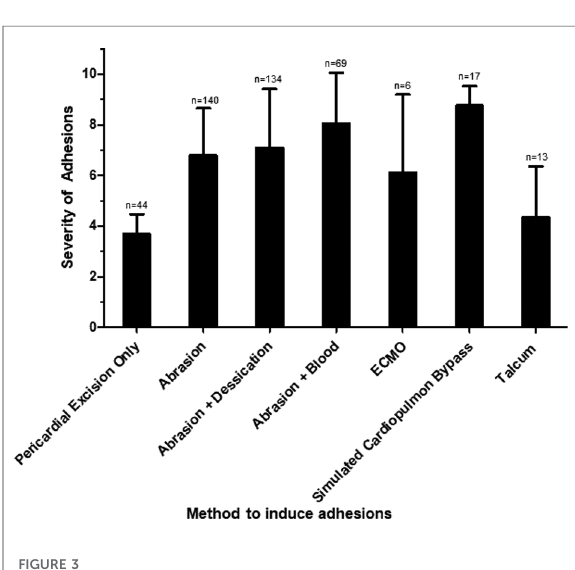
FIGURE 3 Effect of method of adhesion induction on severity of adhesions. The mean severity score for each method is shown, with error bars representing standard deviation. N represents the number of animals used per